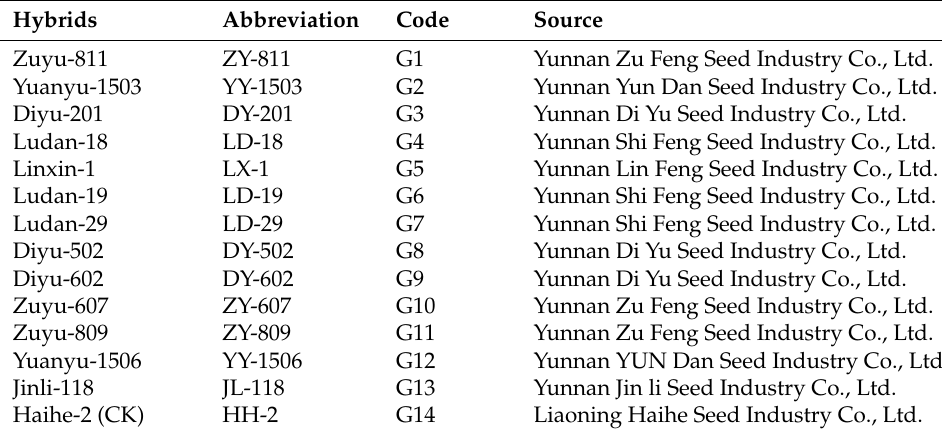
Table 1. Description of 14 maize hybrids used in the